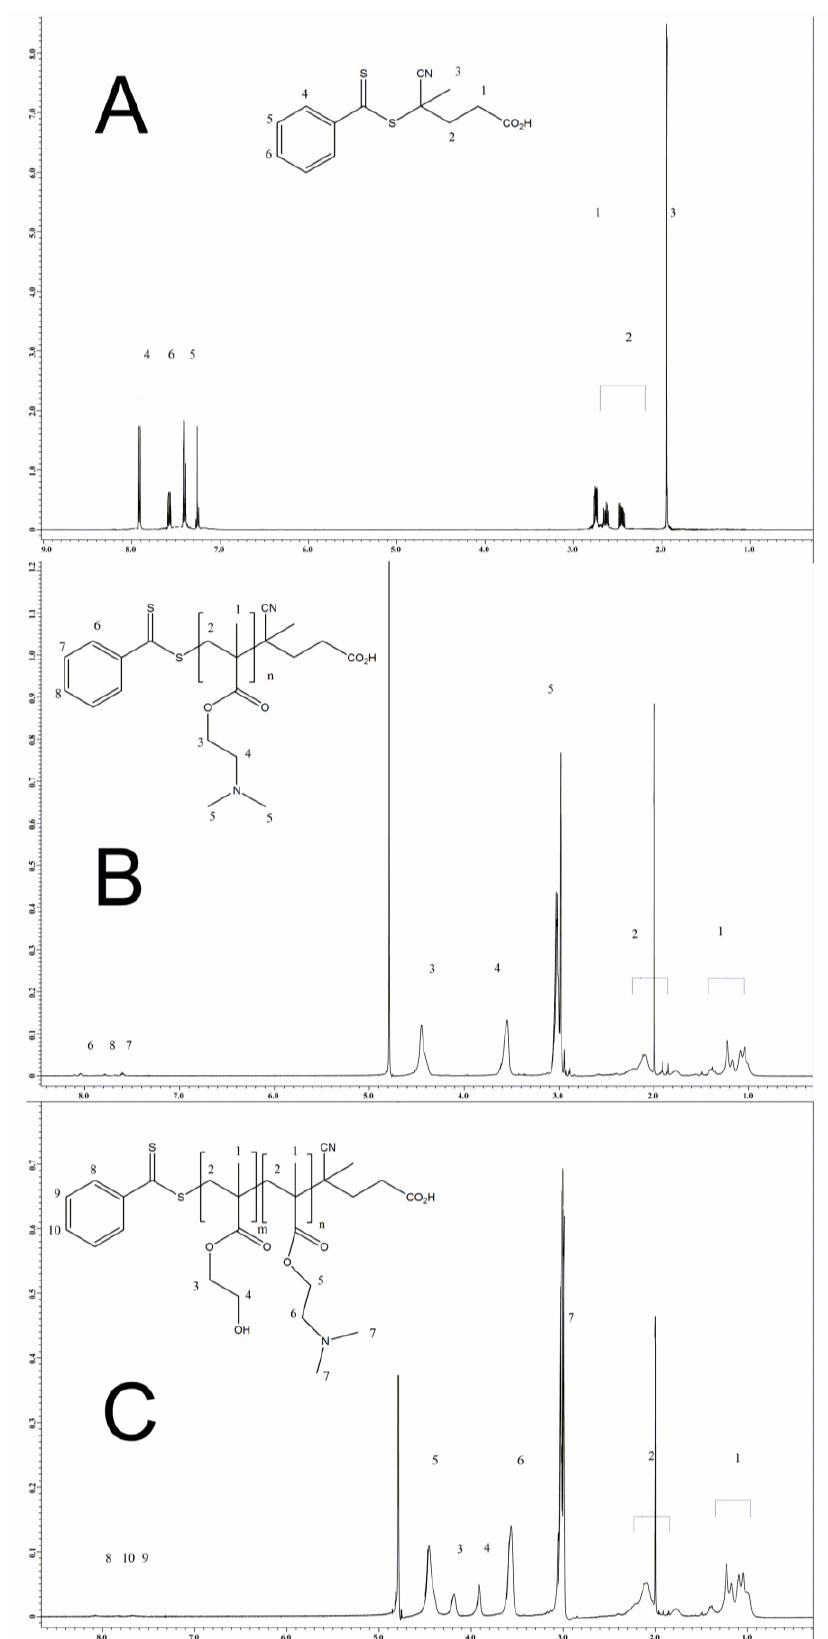
O; the numbers designate the atoms within the 2